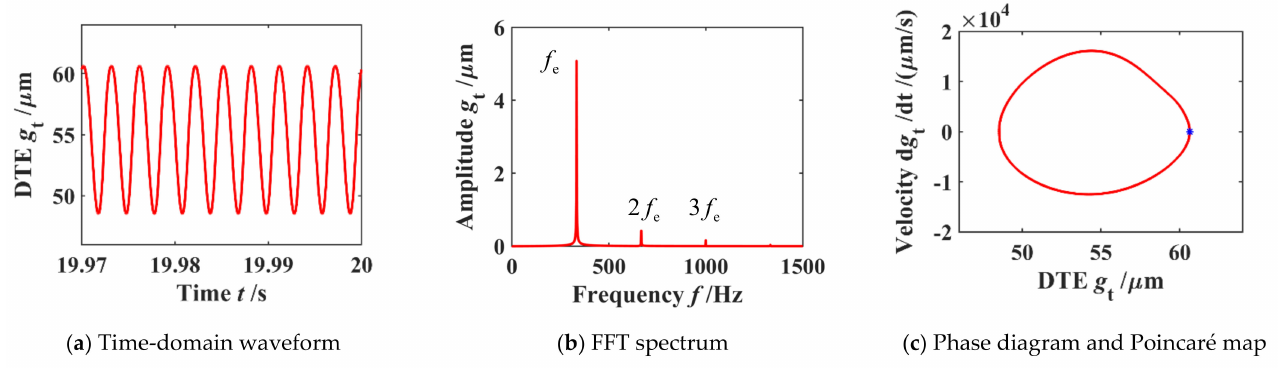
Figure 16. Dynamic responses at n 1 = 1000